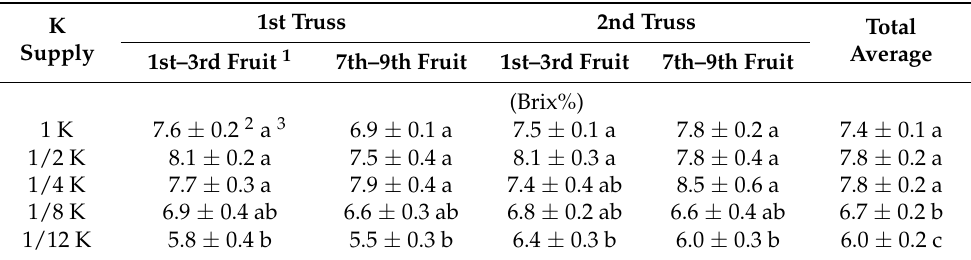
Table 5. Fruit total soluble solid content of hydroponically grown cherry-type tomato ‘Carol 10’ under five quantitative K-supply regimes.